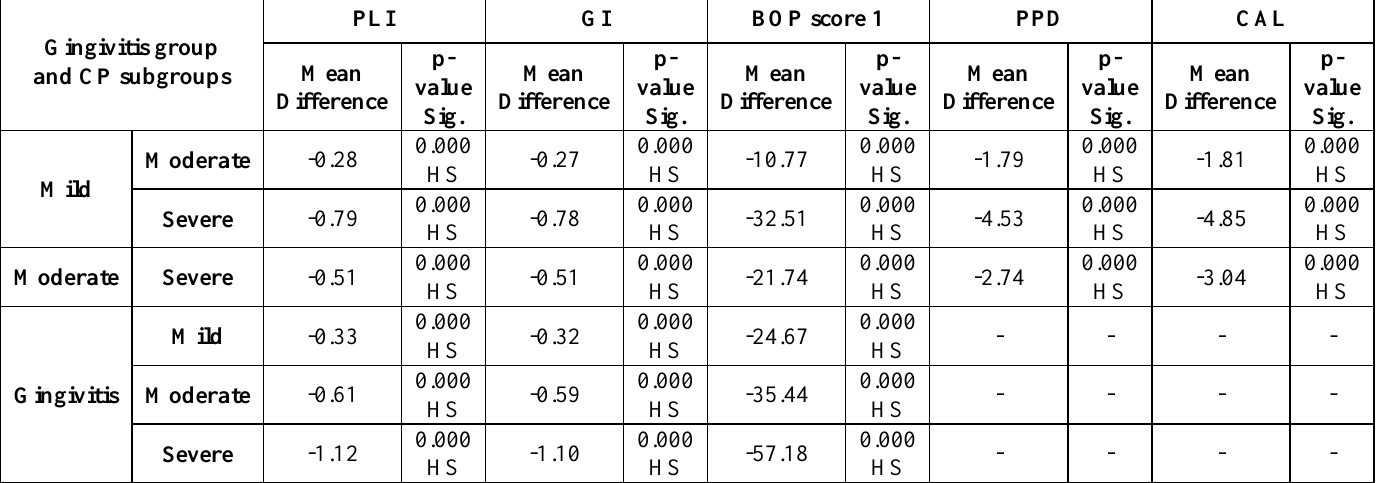
Table 2: Mean differences of the clinical periodontal parameters between all pairs of CP subgroups and with gingivitis